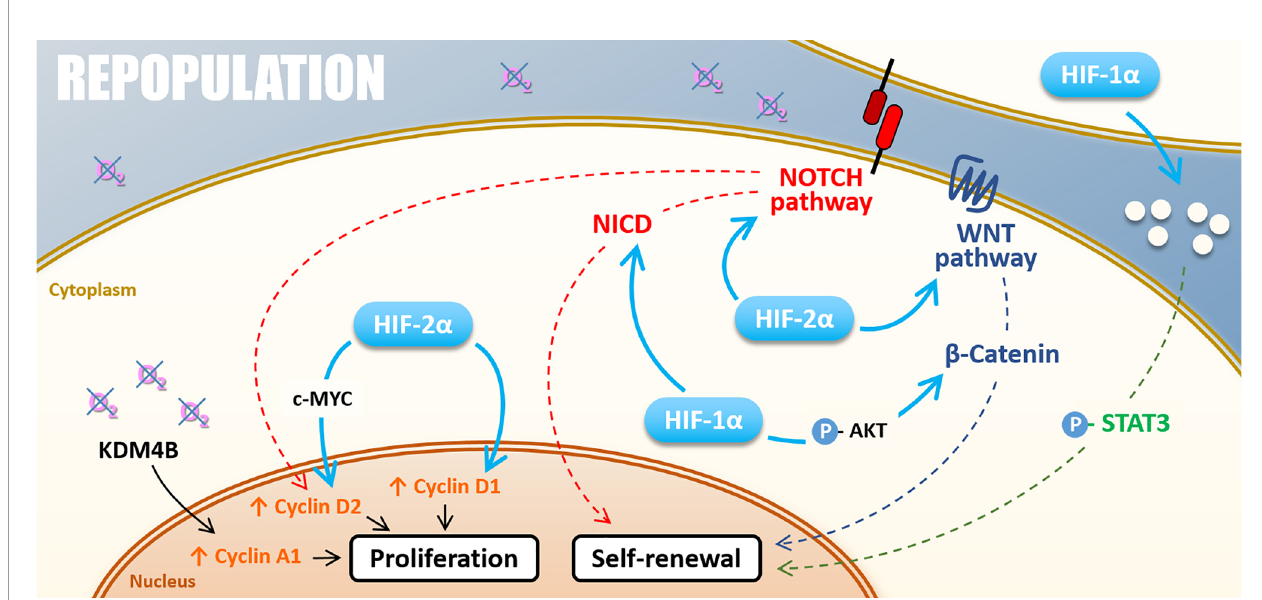
FIGURE 5 | Repopulation. Under hypoxia, cell proliferation can be stimulated by KDM4B-dependant Cyclin A1 up-regulation and Cyclin D2 up-regulation driven by HIF-2 a through c-MYC or thought NOTCH pathway under hypoxia. HIF-2 a also directly induces Cyclin D1 expression. The self-renewal is positively regulated by NOTCH and WNT/ b -catenin pathways activated by both HIF-1 a and HIF-2 a . HIF-1 a also activates the STAT3 pathway and cell renewal through the modi fi cation of cell